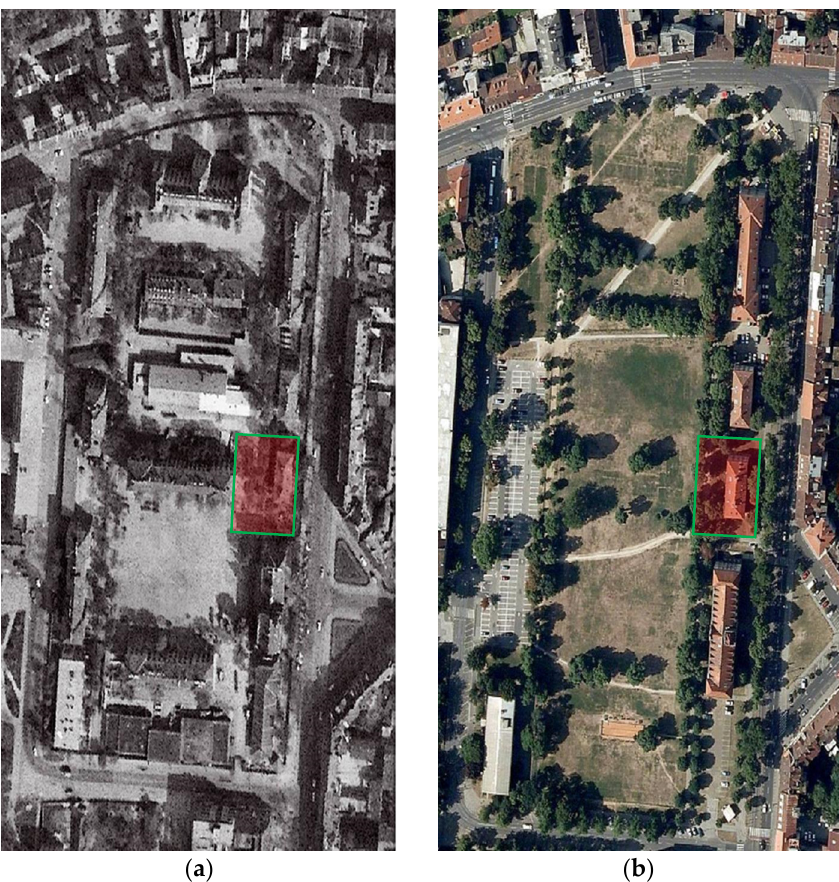
Figure 3. ( a ) Barracks from the end of the 19th century [30]; ( b ) Today’s situation. Figure 4 shows the original drawings of the building in question, obtained from the State Archives in Zagreb.